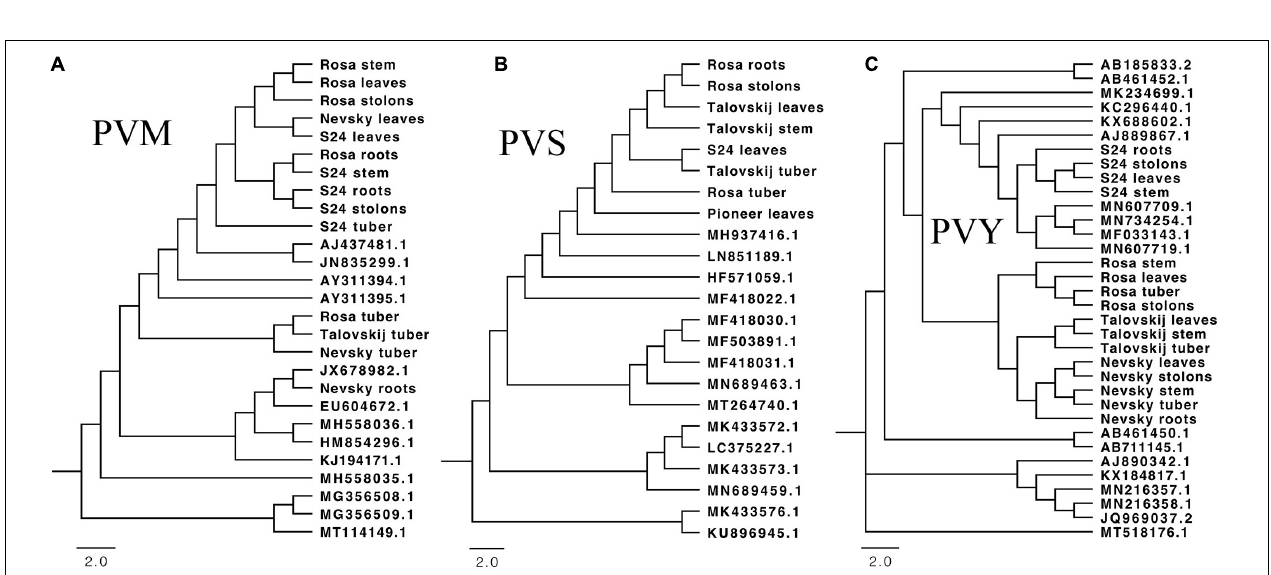
FIGURE 4 | Maximum-likelihood phylogenetic tree of genome sequences for three main identified virus isolates: PVM (A) , PVS (B) , and PVY (C) . The accession number of known isolates is described. We used bootstrap replication values of 1,000. Bootstrap values > 70% are shown.